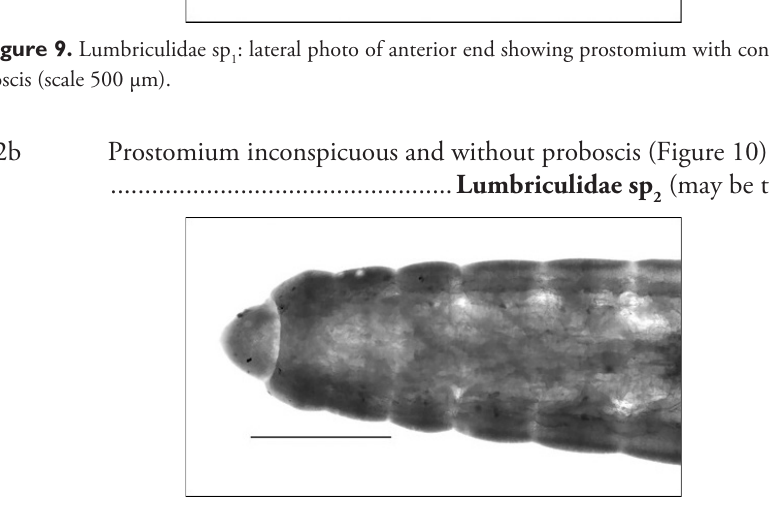
Figure 10. Lumbriculidae sp : photo showing inconspicuous prostomium. 2 13a (11b) Gills present on posterior end (digitiform projections; in some cases incon-